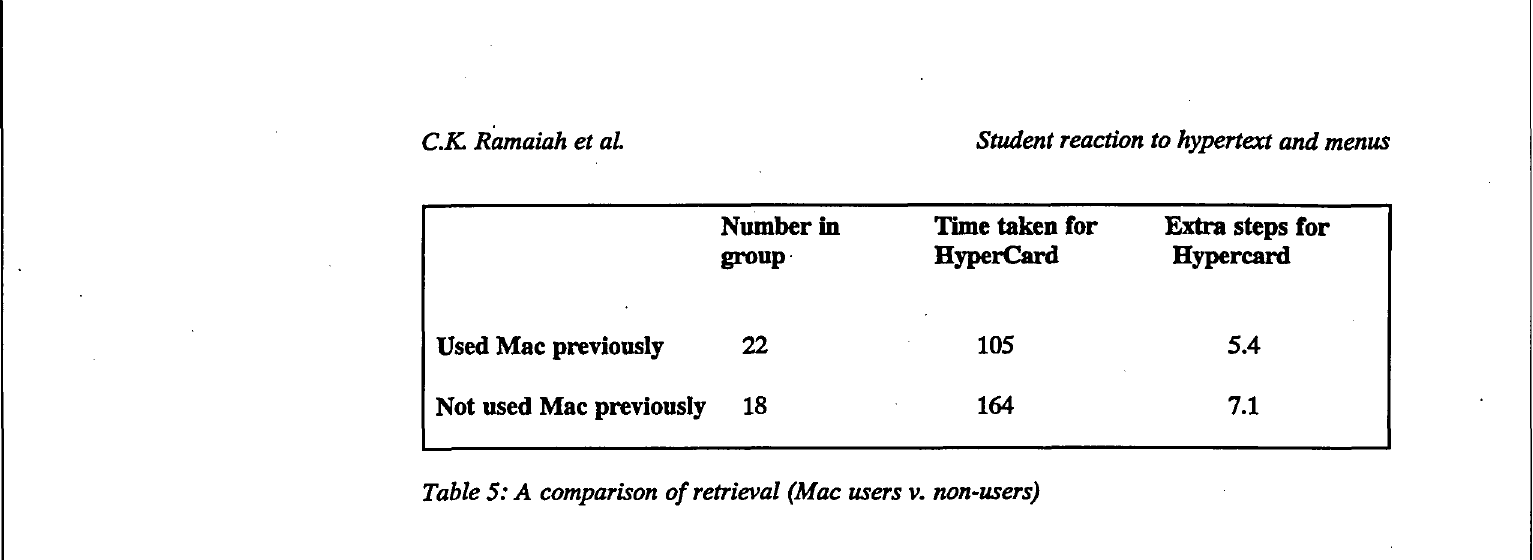
Table 5: A comparison of retrieval (Mac users v. non-users)